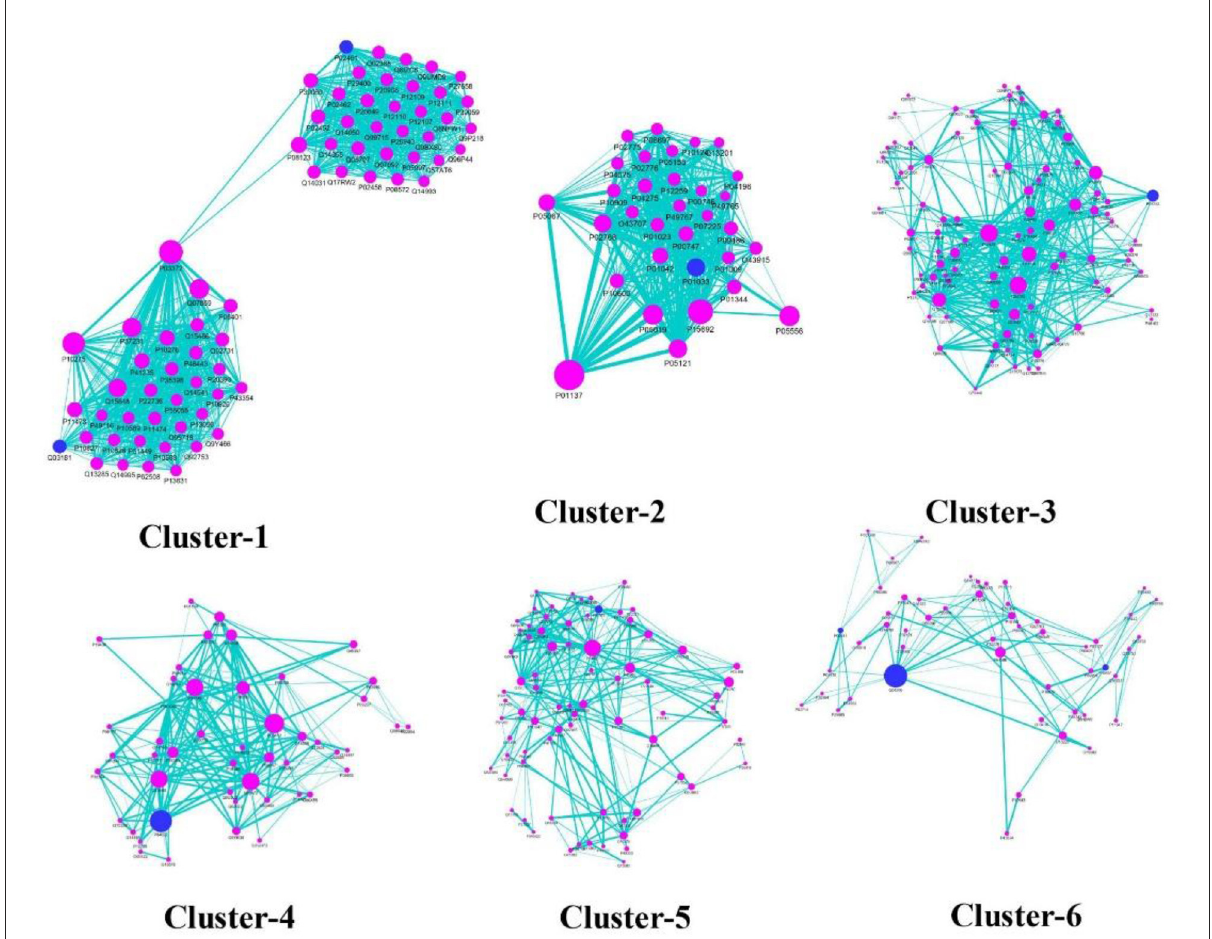
FIGURE8 Cluster analysis of TRH-PIN. Six highly organized and connected topological clusters among the TRH-PIN. The location of ALD protein being targeted by phytochemicals of TC is shown in blue-colored nodes among the clusters, highlighting the direct regulatory role of TC in managing clusters.